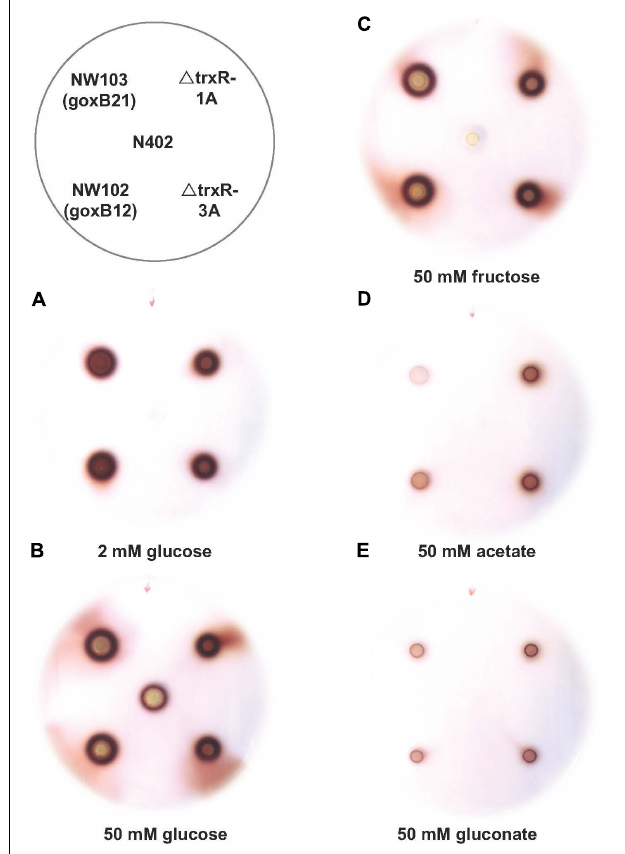
FIGURE 4 | Phenotypic characterisation of trxR gene knock-out strains. Glucose oxidase plate assay of A. niger strain N402, NW102: goxB12 , NW103: goxB21 , (cid:49) trxR -1A, and (cid:49) trxR -3A on various carbon sources: (A) 2 mM glucose, (B) 50 mM glucose, (C) 50 mM fructose, (D) 50 mM acetate, and (E) 50 mM